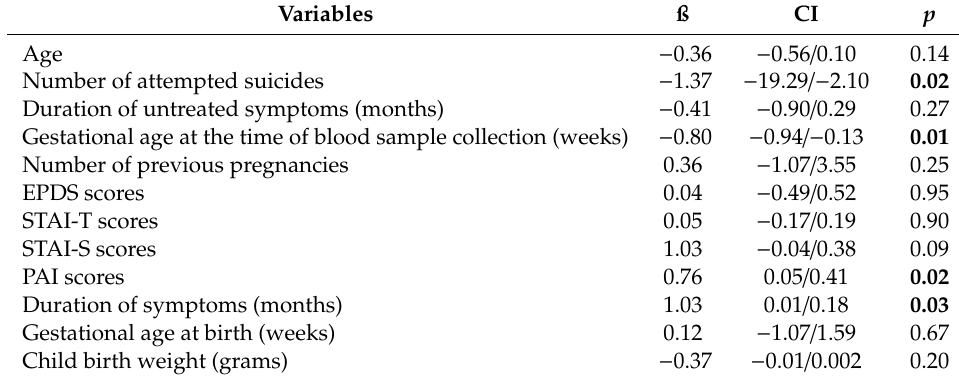
Table 2. Multivariate linear logistic regression model about the association between demographic / clinical variables and plasma Human Endogenous Retrovirus W EnvC7-1 Envelope Protein (ERVWE1)